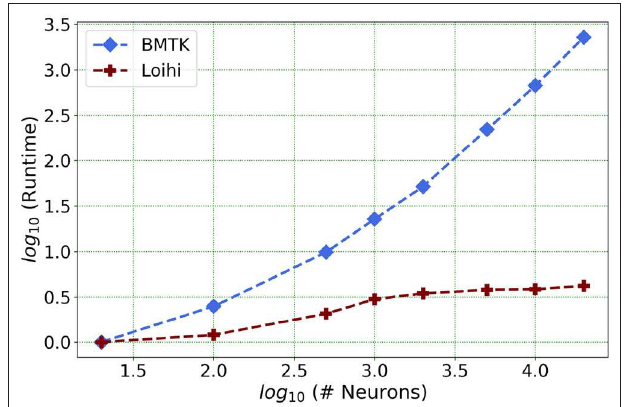
FIGURE 1 | As the network size increases, Loihi outperforms consistently in terms of time. The figure shows runtime comparison of 500 ms of dynamics for up to 20,000 neurons for Loihi and BMTK, with the values scaled by the respective smallest runtime. Loihi has a maximum runtime of up to 12 ms, whereas BMTK runtime goes up to 273 s (See Table 3 for the explicit runtime values and Section 4.4 for further details about the network.).